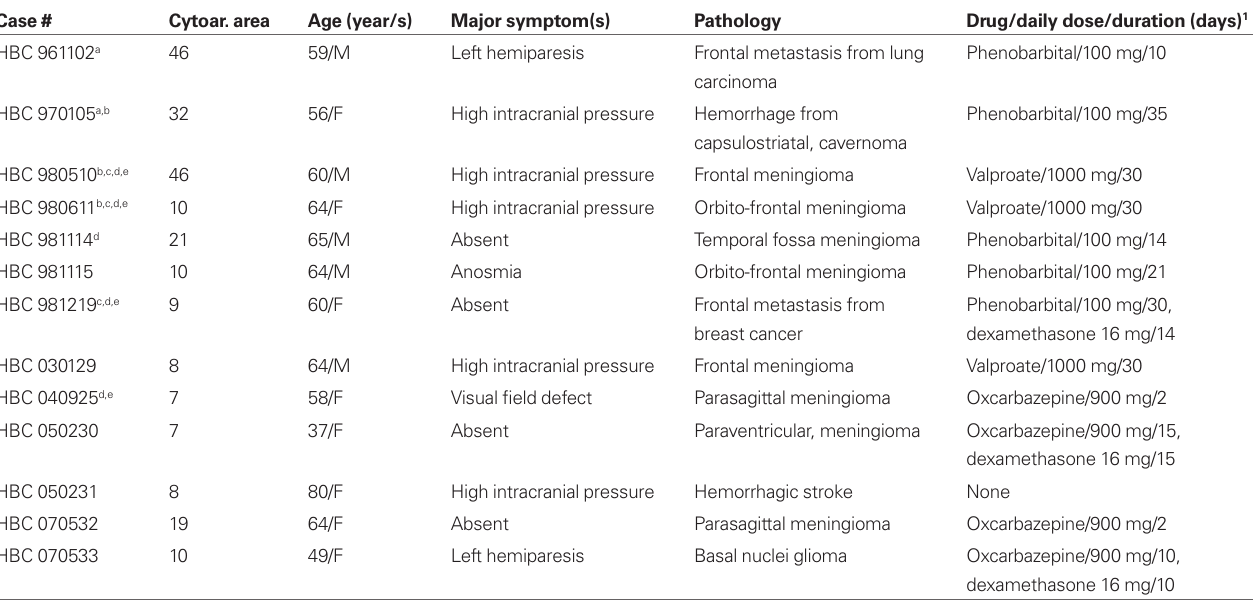
Table 1 | Summary of clinical